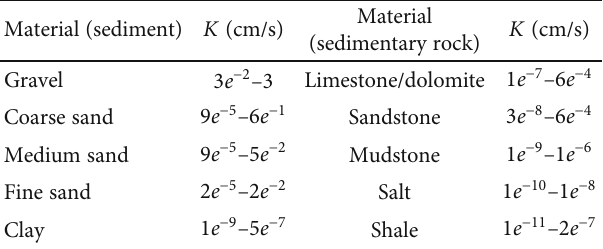
Table 2: Permeability coe ffi cient value ranges for di ff erent types of